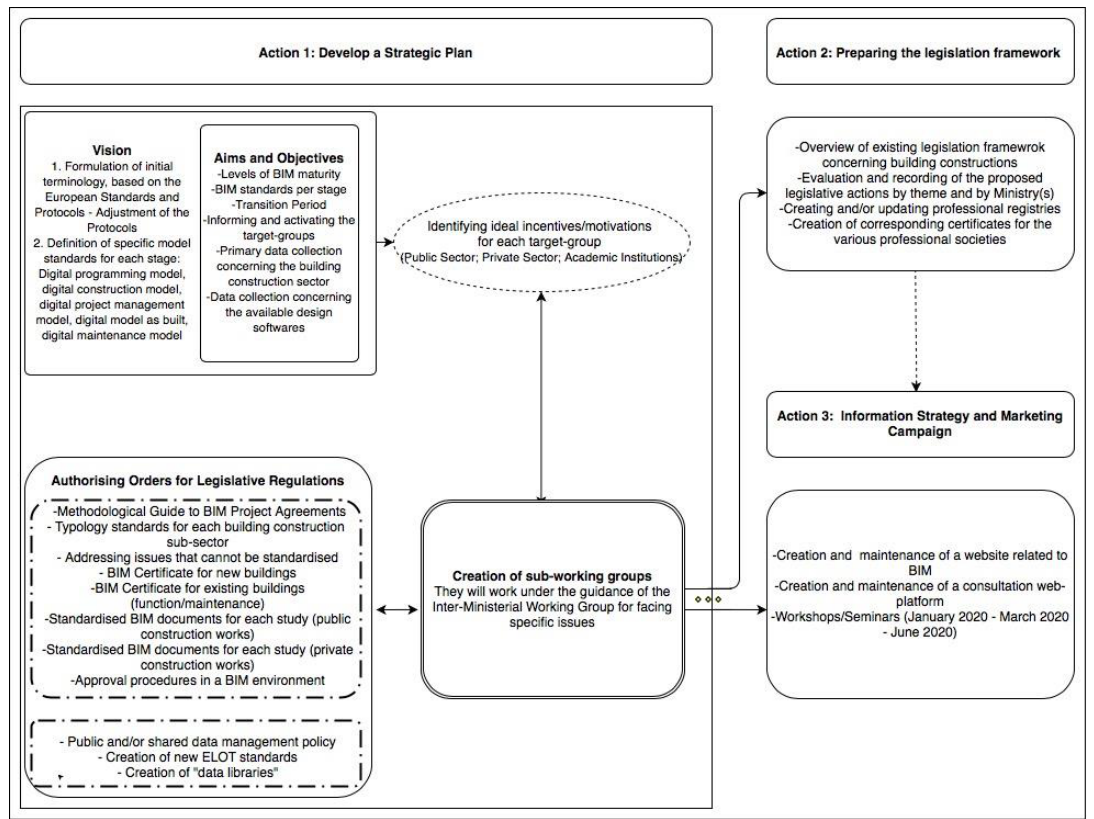
Figure 4. Actions proposed in order for the initial roadmap to be implemented. Source: Own Figure4. Actionsproposedinorderfortheinitialroadmaptobeimplemented. Source: elaboration.